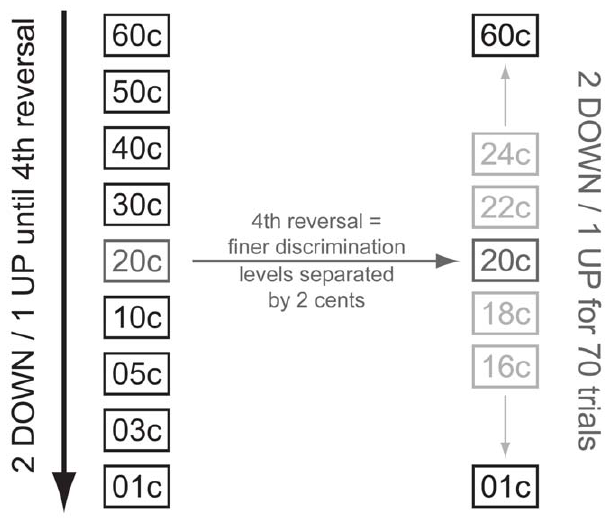
Figure 5. The ‘‘2 down – 1 up’’ adaptive level variation rule used for micromelody discrimination training. For every two correct discrimination trials, the size of the micromelody interval decreased by one level (e.g., 60 c to 50 c), thus making the discrimination task more difficult. If a trial was answered incorrectly, the micromelody interval increased by one level. After four reversals of difficulty level, 70 trials of training for finer discrimination began at the interval scale that elicited the fourth reversal (indicated in dark gray). During this finer discrimination training, the adaptive-level rule was applied again, but each level was separated by only two cents.